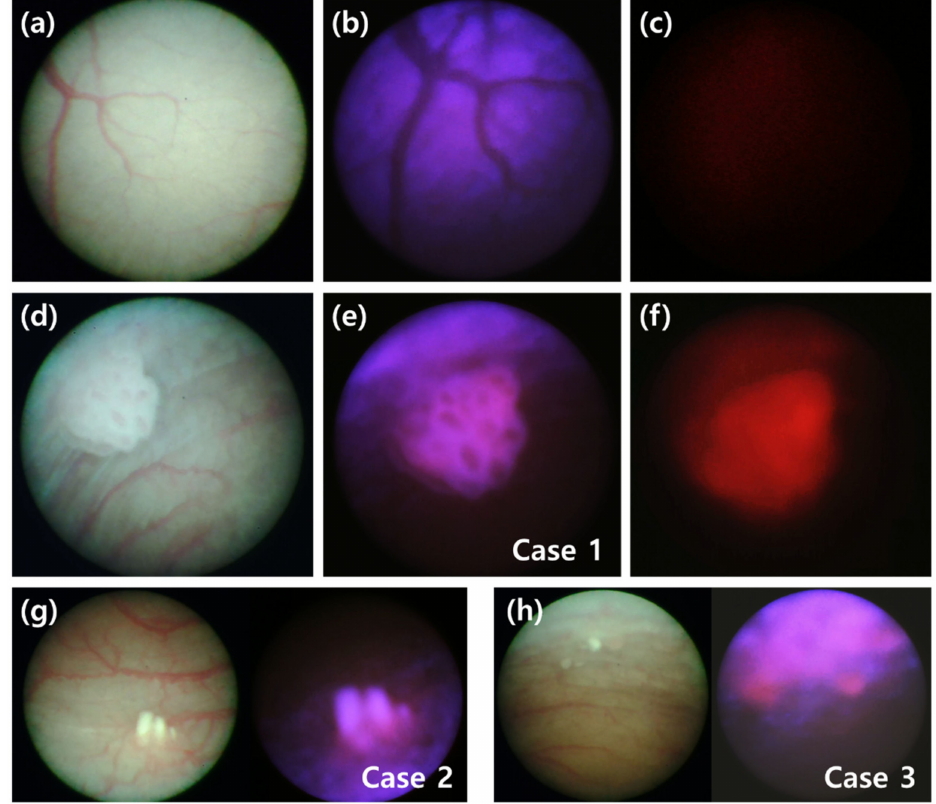
Figure 3. Minimally invasive in vivo brightfield and fluorescence images of bladder in rats. ( a – c ) The inside of a healthy bladder, imaged with ( a ) brightfield illumination, ( b ) excitation filter only, and ( c ) with an excitation filter and emission filter both inserted. ( d – f ) Images of the inside of a bladder with cancerous lesions taken with ( d ) brightfield illumination, ( e ) excitation-filtered illumination, and ( f ) both excitation and emission filters at week 13 following BBN treatment (Case 1). ( g , h ) Cases 2 and 3 show additional cases of bladder cancer in other